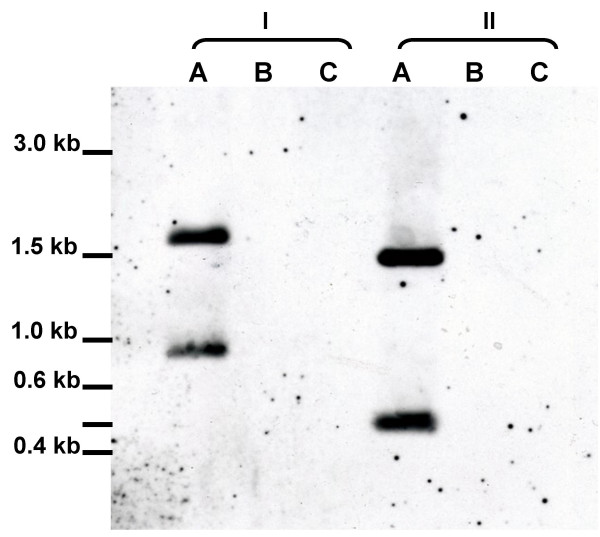
Southern blot hybridization of Carp and KHV DNA with the TK gene. KHV (A) and Carp (B) DNA were digested with BsaAI (I) or PvuII (II) and hybridized with a labeled TK probe. BCG (Bacillus Calmette Guerin) DNA (C) was used as a negative control.